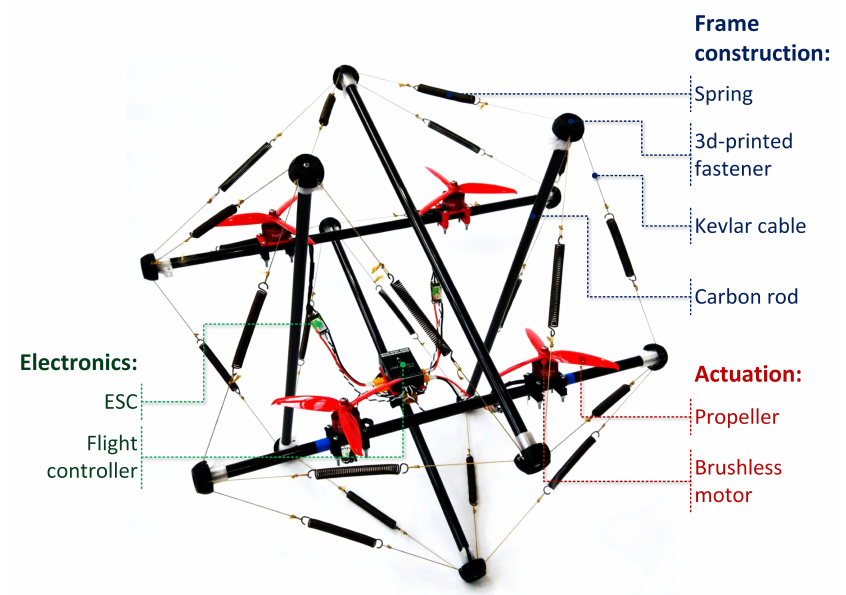
Figure 7. Pure tensegrity drone; ESC stands for Electronic Speed Controller; the flight controller used is PX4.